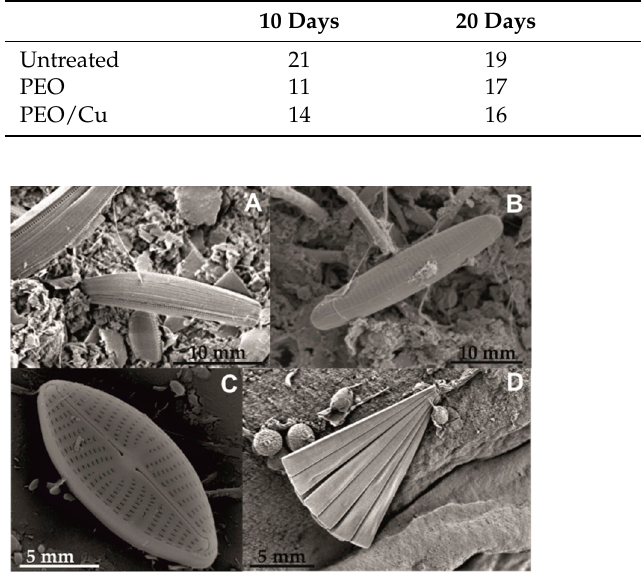
Table 3. Number of taxa registered on the different samples during the experimental period.